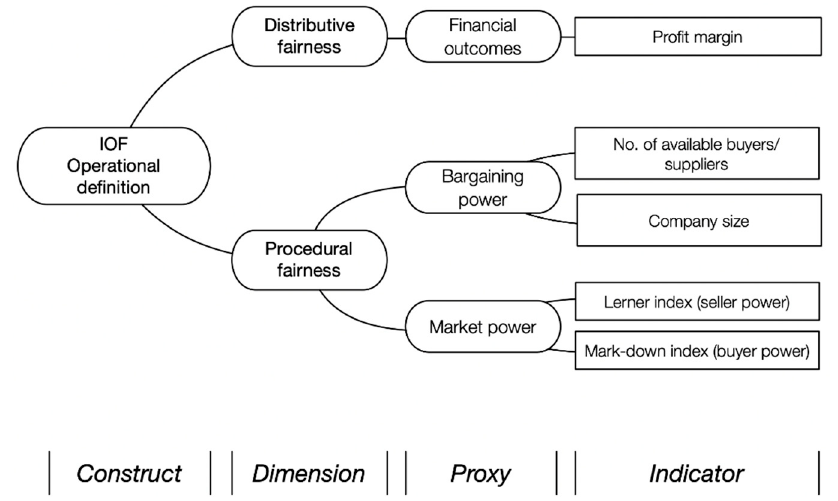
Figure 5. Resulting measurement framework of IOF.